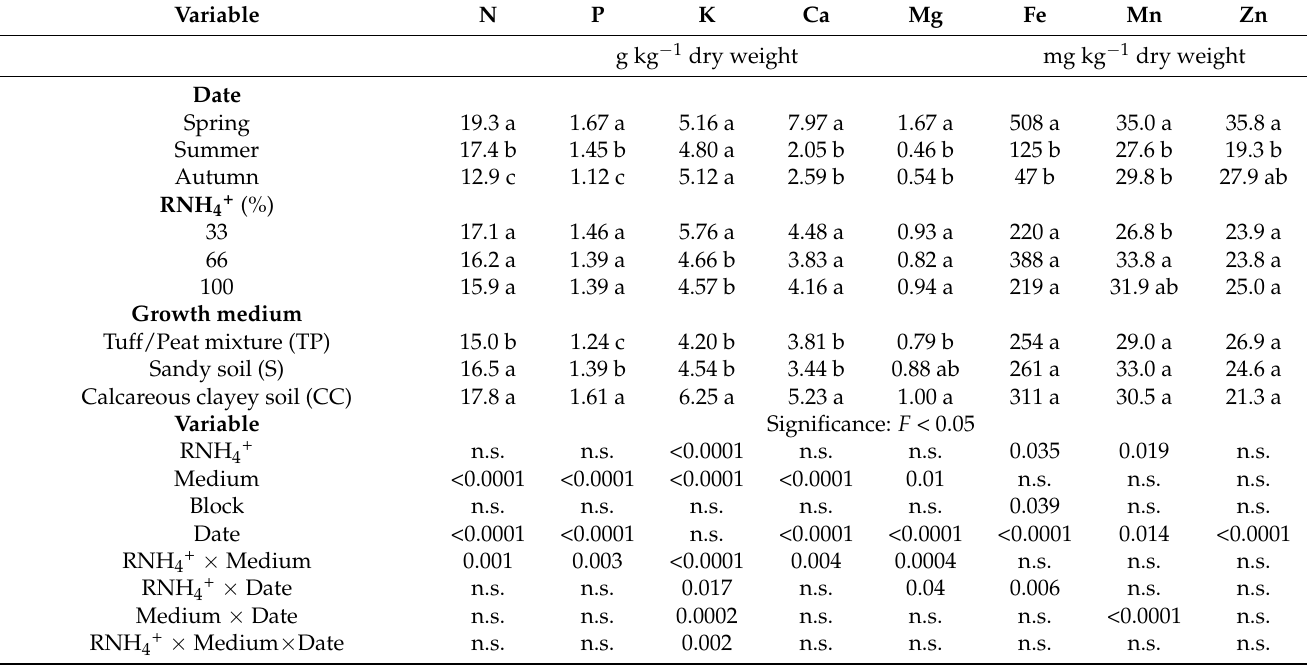
Table 6. The effects of the proportion of N-NH 4+ among the total applied inorganic N (RNH 4+ ) sandy soil (S) and calcareous, clayey soil (CC)] on nutrient concentrations in the diagnostic leaves